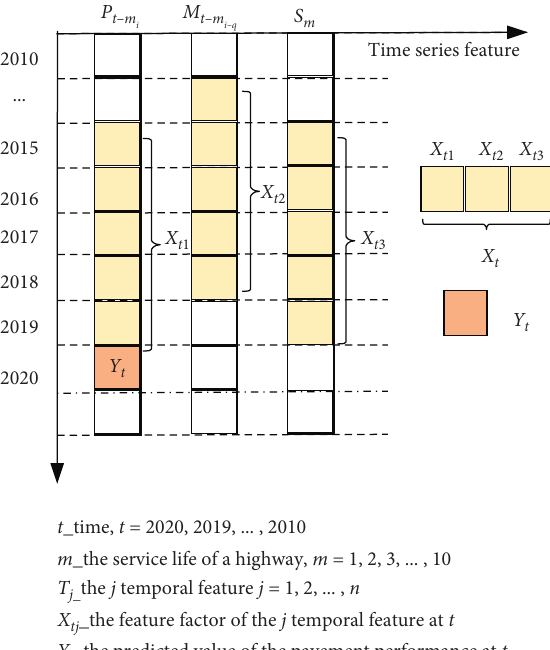
Figure 11: Time series feature extraction of the Dalian highway.